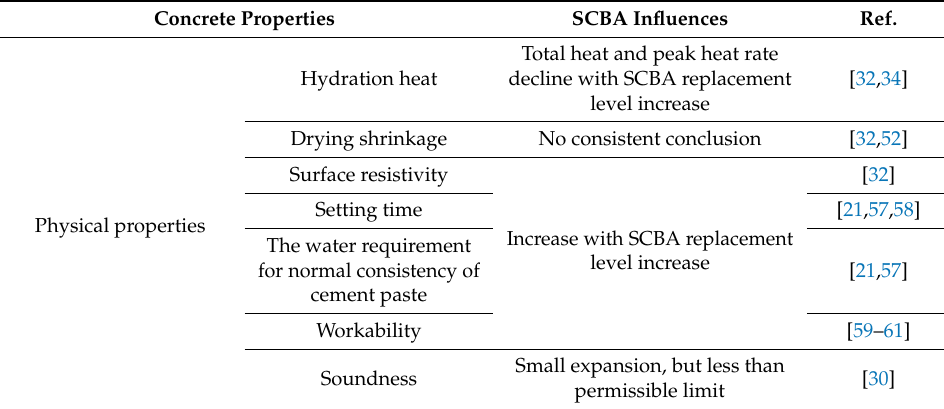
Table 2. SCBA impacts on concrete